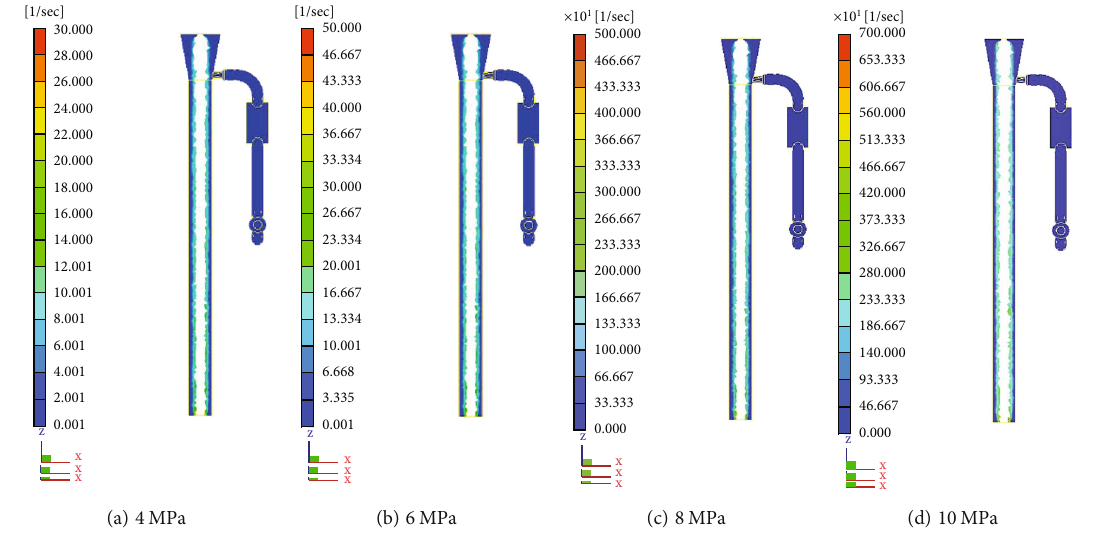
Figure 8: Shear rate distribution at di ff erent water injection